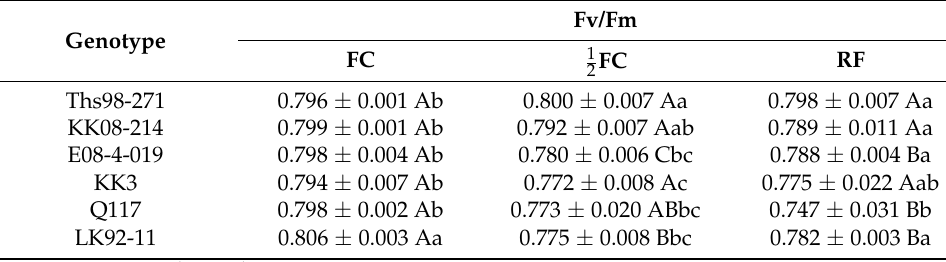
Table 4. Maximum quantum yield of PSII efficiency (Fv/Fm) of six sugarcane genotypes under early drought conditions (determined four months after